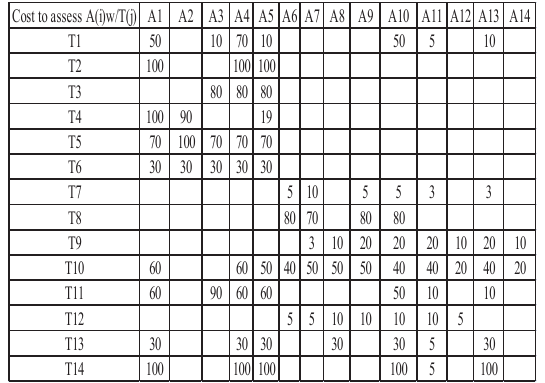
Table 2: Risk Assessment Techniques and the Costs of assessing them